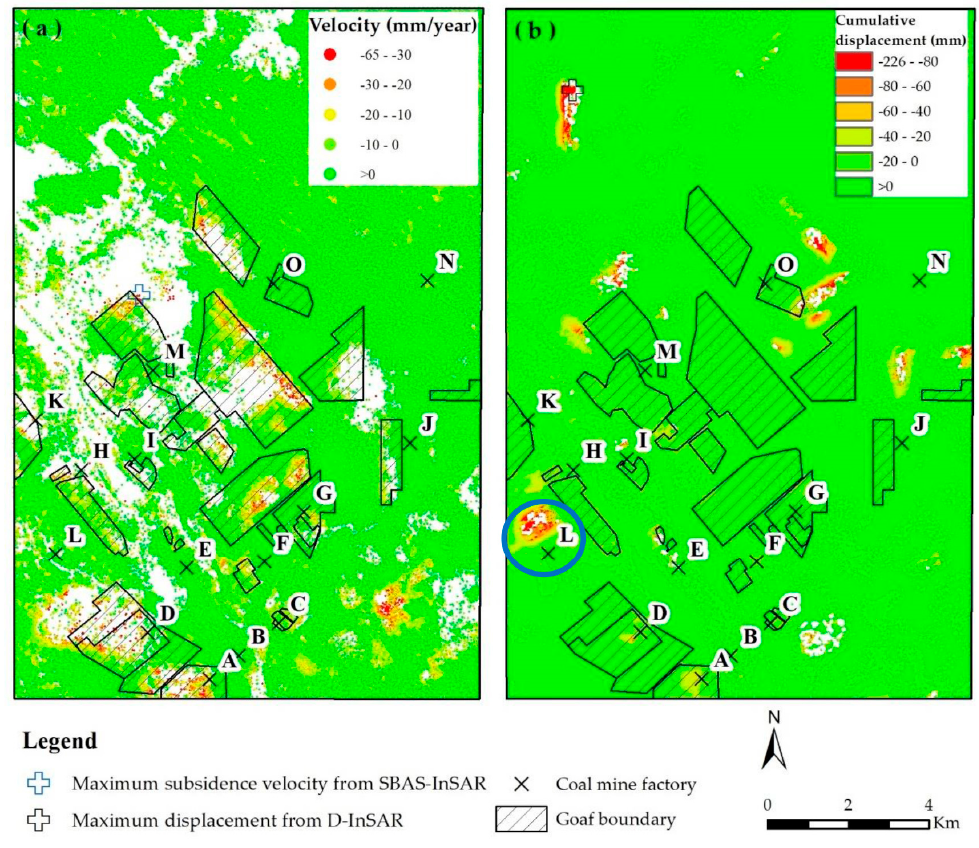
Figure 3. ( a ) Distribution of land subsidence velocity derived with SBAS-InSAR technique from December 2006 to January 2011; ( b ) Distribution of the cumulative displacement through DInSAR technique from December 2014 to July 2015.